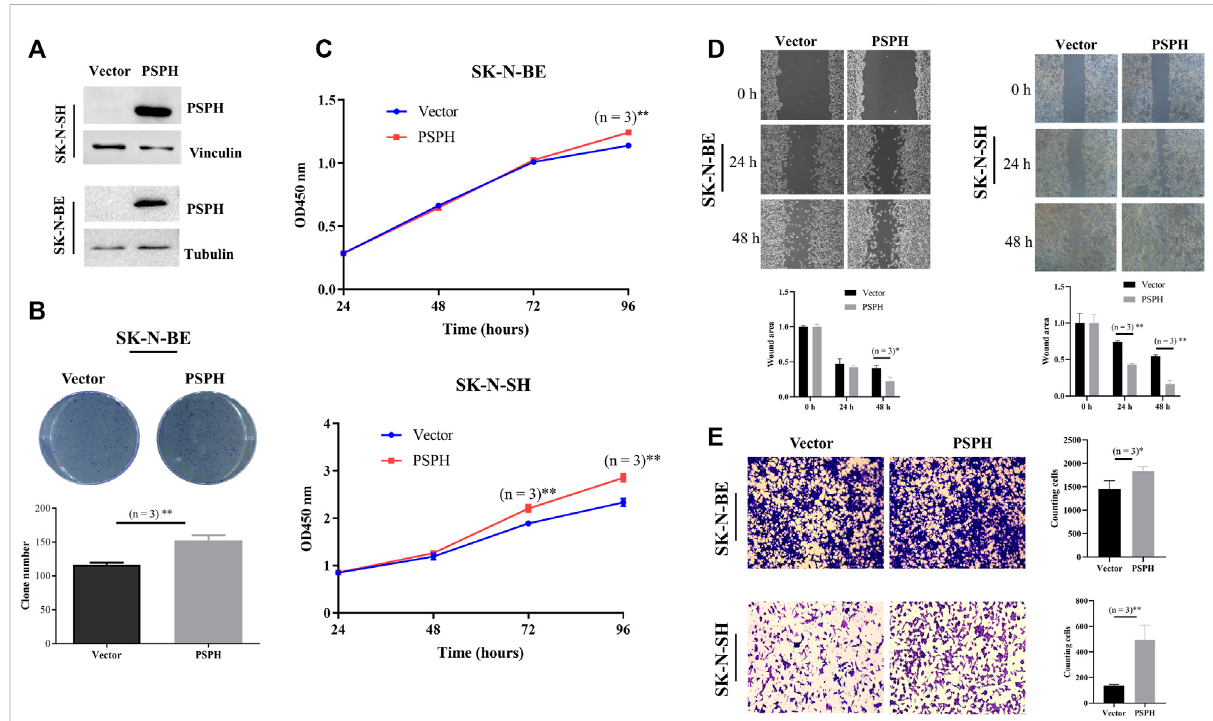
FIGURE 3 PSPH promoted cell proliferation and invasion of NB cells in vitro . (A) Western blot assay indicating the level of PSPH in two NB cell lines stably transfectedwithemptyvectorandPSPH(SK-N-SHandSK-N-BE); (B) Representativeimagesofcloneformationandstatisticalanalysisindicatingcell proliferationofhumanSK-N-BEcelltreatedasindicated; (C) CCK8assaydescribingthechangesofcellviabilityofSK-N-BEandSK-N-SHcellsstably transfected with vector and PSPH treated as indicated; (D) Wound-healing assay of SK-N-BE and SK-N-SH cells exposing to vector and PSPH treated as indicated for 24 and 48 h independently; (E) Representative images (left panel) and quanti fi cation (right panel) of Matrigel invasion assay indicating the invasion ability of SK-N-BE and SK-N-SH cells stably transfected as indicated. The data in (B – E) are presented as mean ± SD of triplicate experiments, * p < 0.05, ** p <